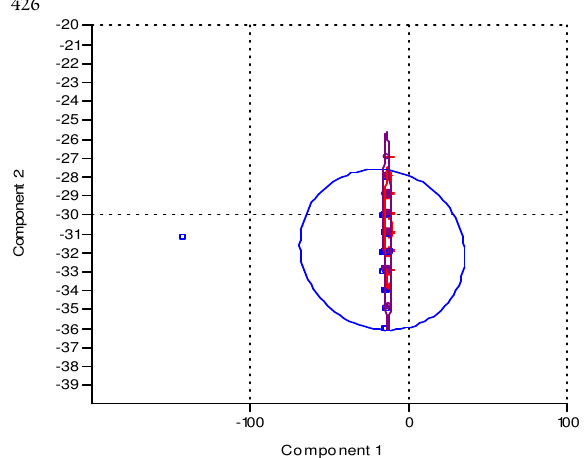
Fig. 5. Principal components analysis based on six meristic counts of T. zillii from Opa Reservoir: (red) Igun Reservoir: (purple) and Osu Reservoir (blue) showing homogeneity of 157 and 94 respectively (Table 3). There was no band that was population specific.